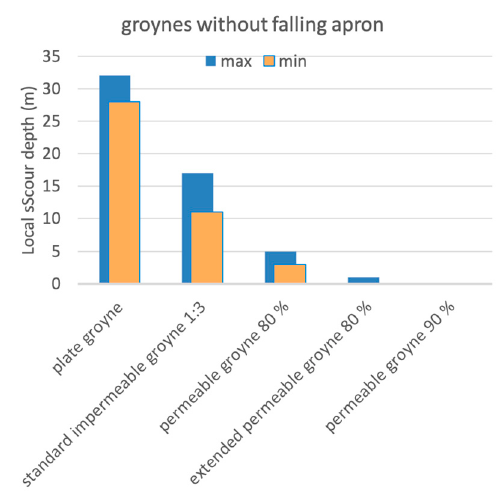
Figure 7. The maximum local scour depth near di ff erent types of groynes without falling aprons in physical model tests.